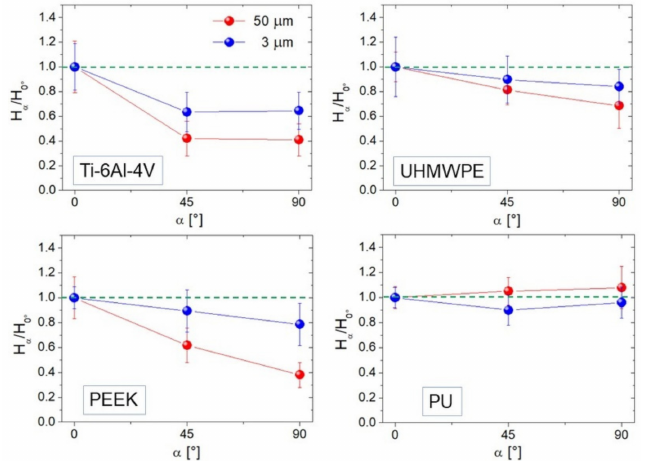
Figure 7. H α /H 0 ◦ ratios for α = 45 ◦ and 90 ◦ calculated at L = 50 (red curve) and 3 µ m (blue curve). The green dotted lines indicate unity (full isotropy) for the reader’s